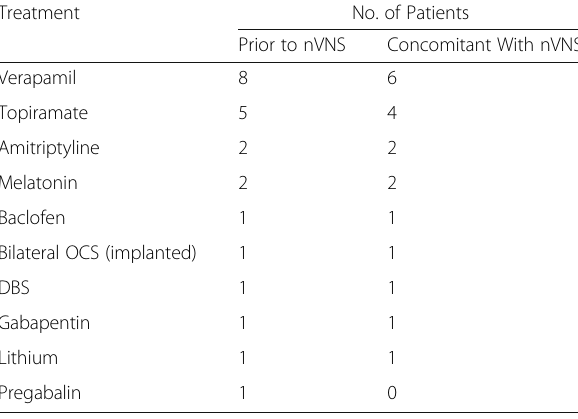
Table 4 Summary of acute and preventive medication use before and after the establishment of nVNS therapy